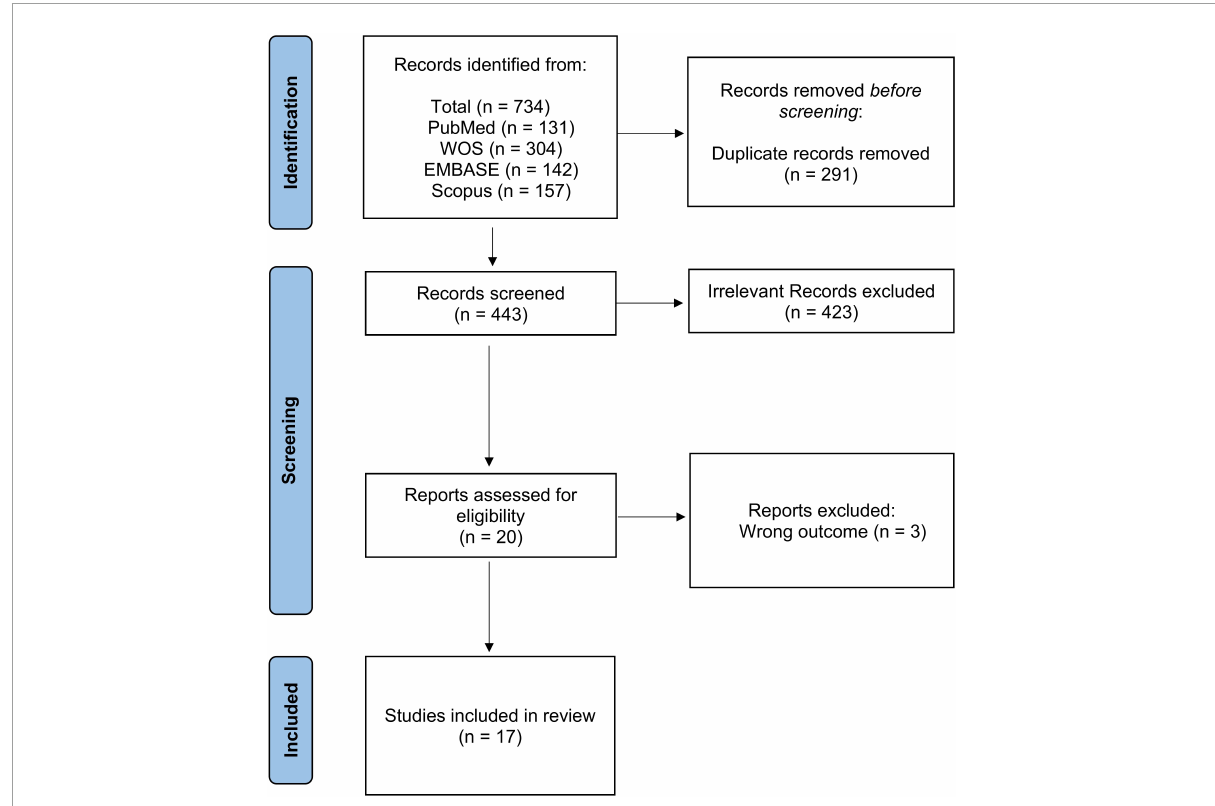
FIGURE1 Preferred reporting items for systematic reviews and meta-analyses (PRISMA) flow chart. Legend to figure: PRISMA flow diagram for the included studies showing the selection